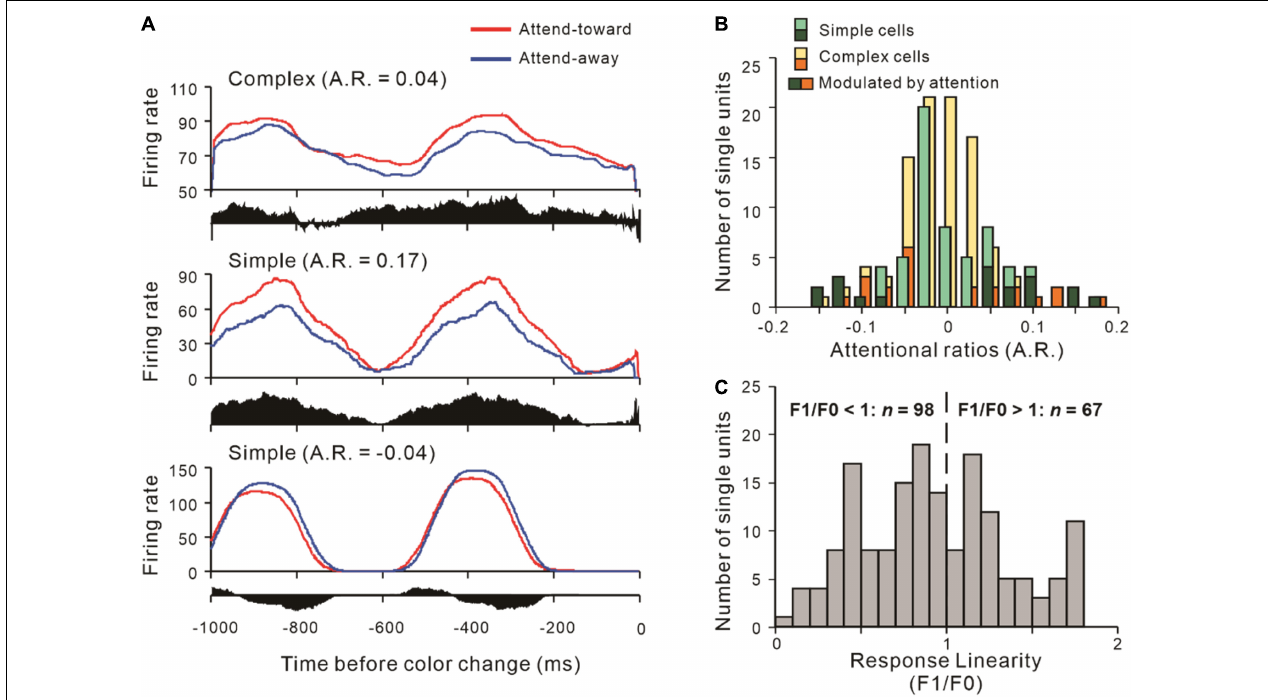
FIGURE 2 | Examples of V1 simple and complex cells and their distributions of attentional ratio. (A) Examples of neurons whose firing rates were modulated by spatial attention. The PSTHs show neuronal responses to drifting gratings 1 s before the color change, while the response difference between AT and AA is represented by the black histogram under it. Attentional ratio (A.R.) = (AT – AA) / (AT + AA). A complex (upper) and a simple cell (middle) showed attention-related response enhancement (A.R. > 0), and another simple neuron (down) with spiking response suppression (A.R. < 0). The red solid line indicates the neuronal responses when attention is directed to its RF, while the spiking responses of the attend-away condition are represented by the blue line. (B) The number of simple and complex cells with different attentional ratios of firing rate. Several simple (dark green) and complex cells (orange) whose responses were significantly modulated by attention, while others were not (light green: simple cells; yellow: complex cells). (C) The distribution of response linearity of 165 V1 neurons across all recording